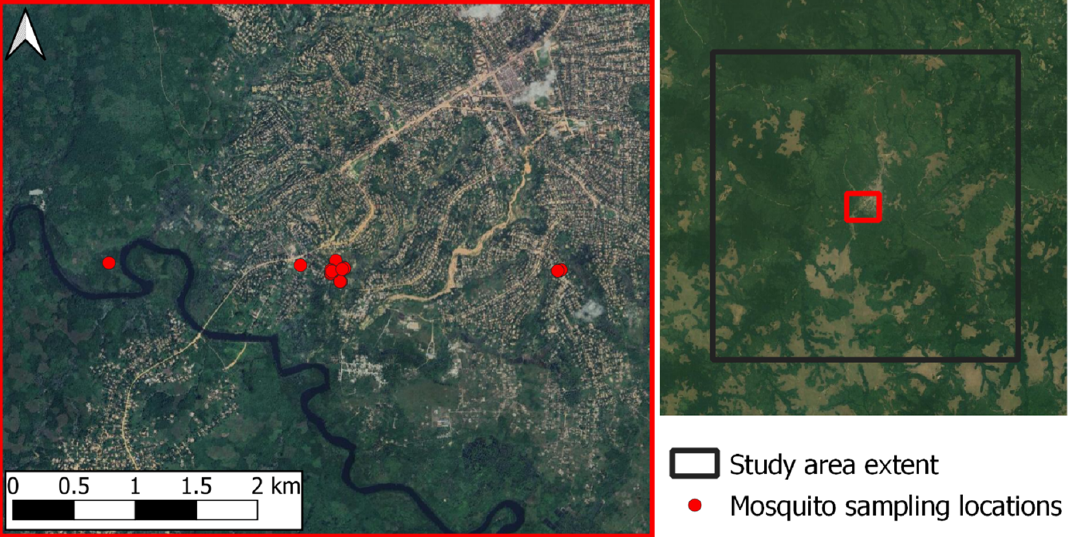
Figure 2. Mosquito sampling locations in Lodja. The area surrounding the sampling locations comprises a heterogeneous mix of built-up areas, trees, grassland, fallow areas, and static water (fish ponds).